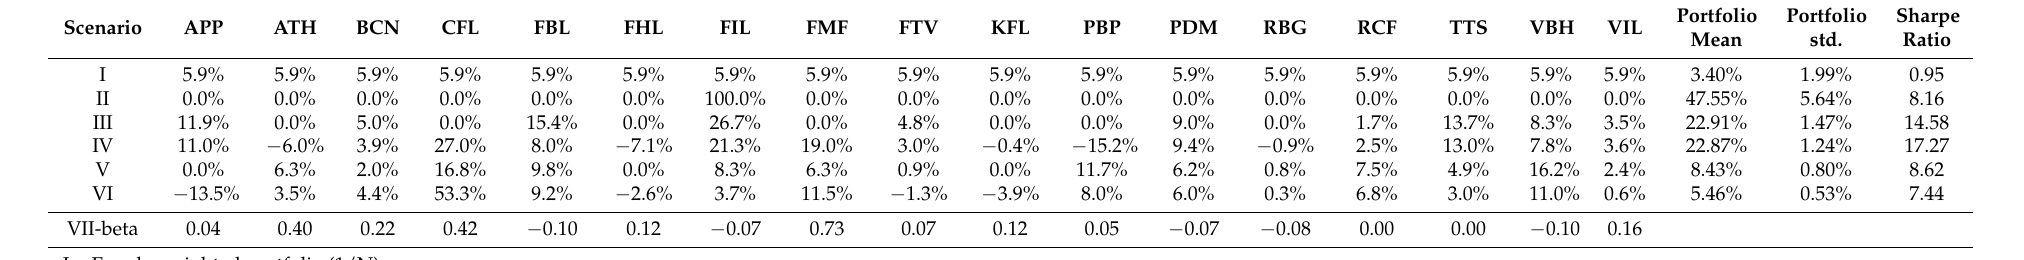
Table 16. Portfolio Weights Based on Mean-Variance with Different Scenarios.